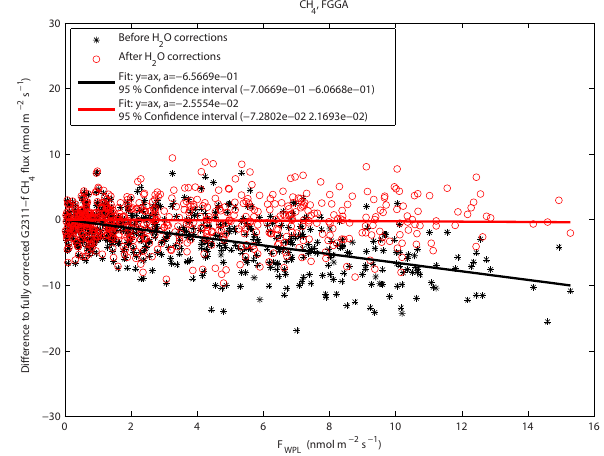
Figure 9. Difference between FGGA CH 4 fluxes and fully cor- rected G2311-f CH 4 fluxes before (black markers) and after (red markers) H 2 O corrections are applied to FGGA CH 4 data. F WPL was calculated with H 2 O covariance, w 0 χ 0 v ,